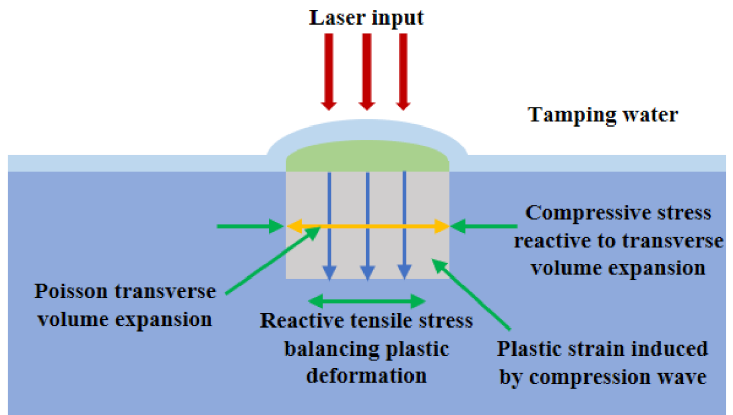
Figure 5. Schematic diagram of the laser peening